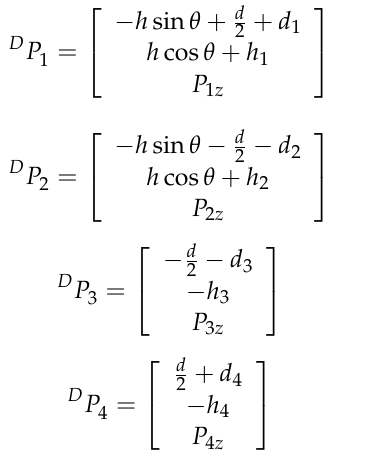
Figure 6. Kinematic relations of the moveable platform. Points C i are centers of the rotating joints connecting all elements of the articulated quadrangle of the moveable platform. Points P i 1 and P i 2 are the centers of spherical joints connected with the moveable platform. The location of points P i (which are the centers of the segments connecting points P i 1 and P i 2 ) might be expressed as the functions of orientation of the final end-effector θ and some geometric constants ( d , d i , h , h i ):